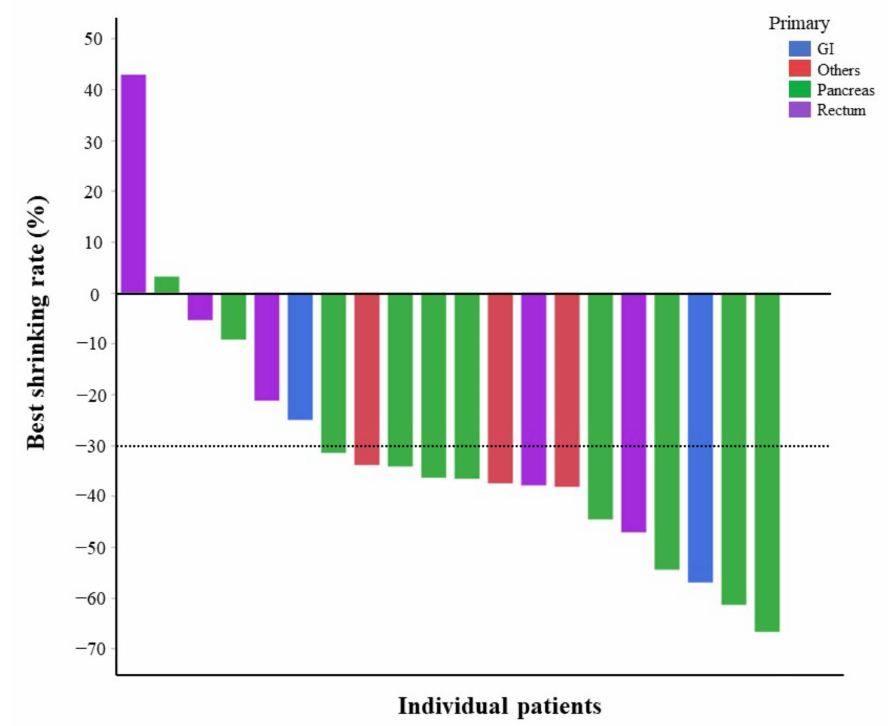
Figure 2. Waterfall plot showing the best shrinkage rate by PRRT in patient-based analysis. Green line, primary site of pancreas; blue line, primary site of gastrointestinal tract; purple line, primary site of rectum; red line, primary site of others. PRRT, peptide receptor activation therapy.